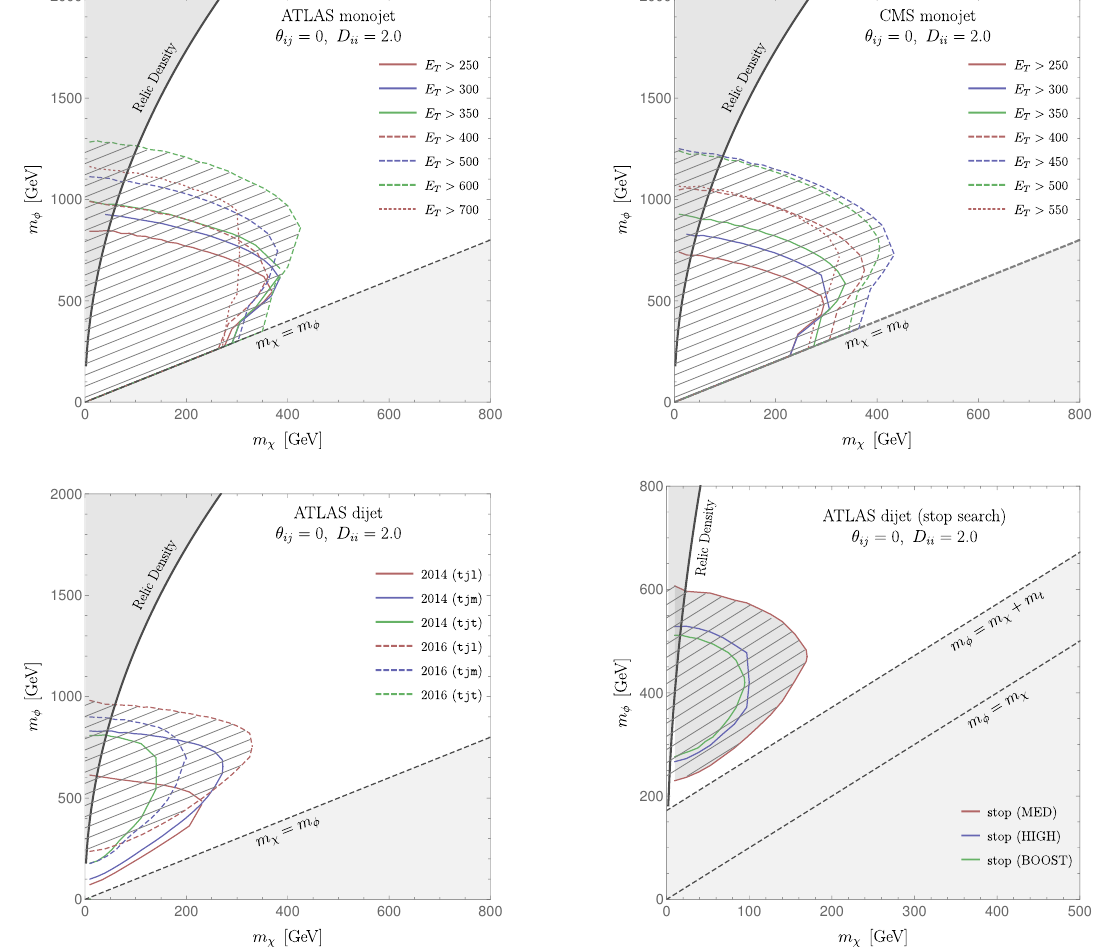
Figure 13 . Exclusion regions for di(cid:11)erent signal regions in the ATLAS (top left) and CMS (top right) monojet analyses, ATLAS dijet searches (bottom left), and ATLAS stop searches (bottom